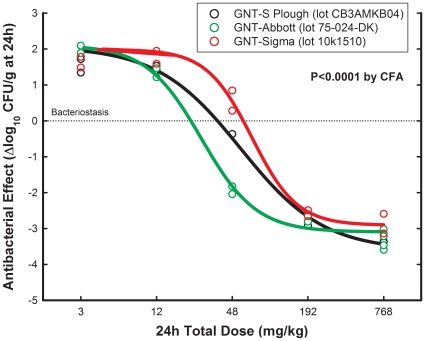
Unpredictability of therapeutic equivalence from pharmaceutical equivalence.The graph illustrates the dose-response curves of gentamicin made by three well-reputed makers: Abbott, Sigma and S. Plough. Abbott and Sigma were indistinguishable from S Plough in terms of concentration and potency of the active pharmaceutical ingredient, MIC, MBC, MBC/MIC ratios but significantly different in terms of therapeutic efficacy, although the same batch of each product was tested in vitro and in vivo.